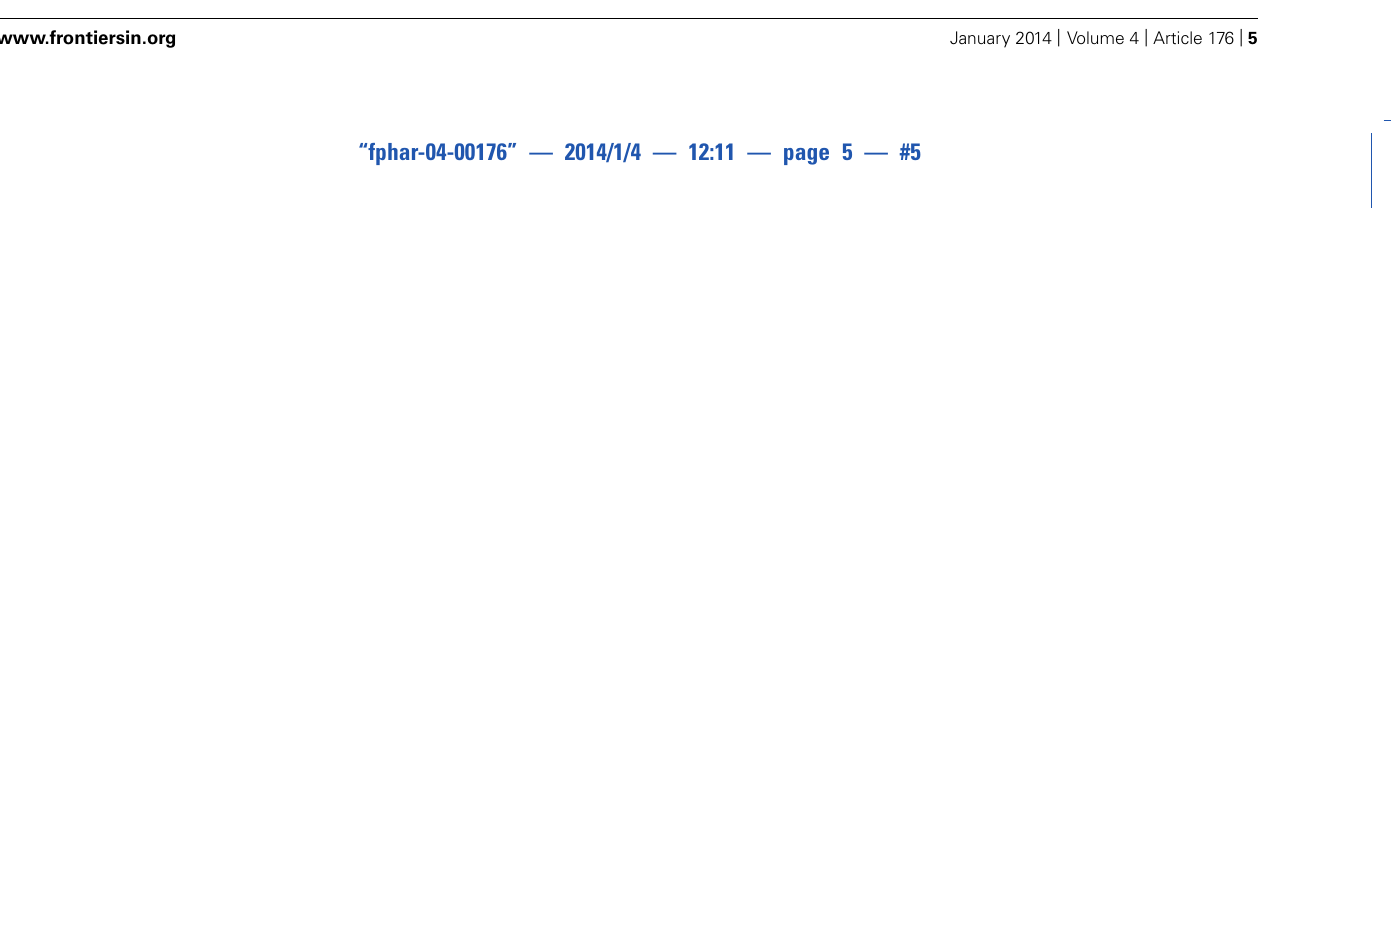
and platelet 12(S)-LOX generate oxylipins that have either prothrombotic (green box) or anti-thrombotic (red box) signaling properties. Oxylipins designated with yellow boxes have been reported as pro and anti-thrombotic in the